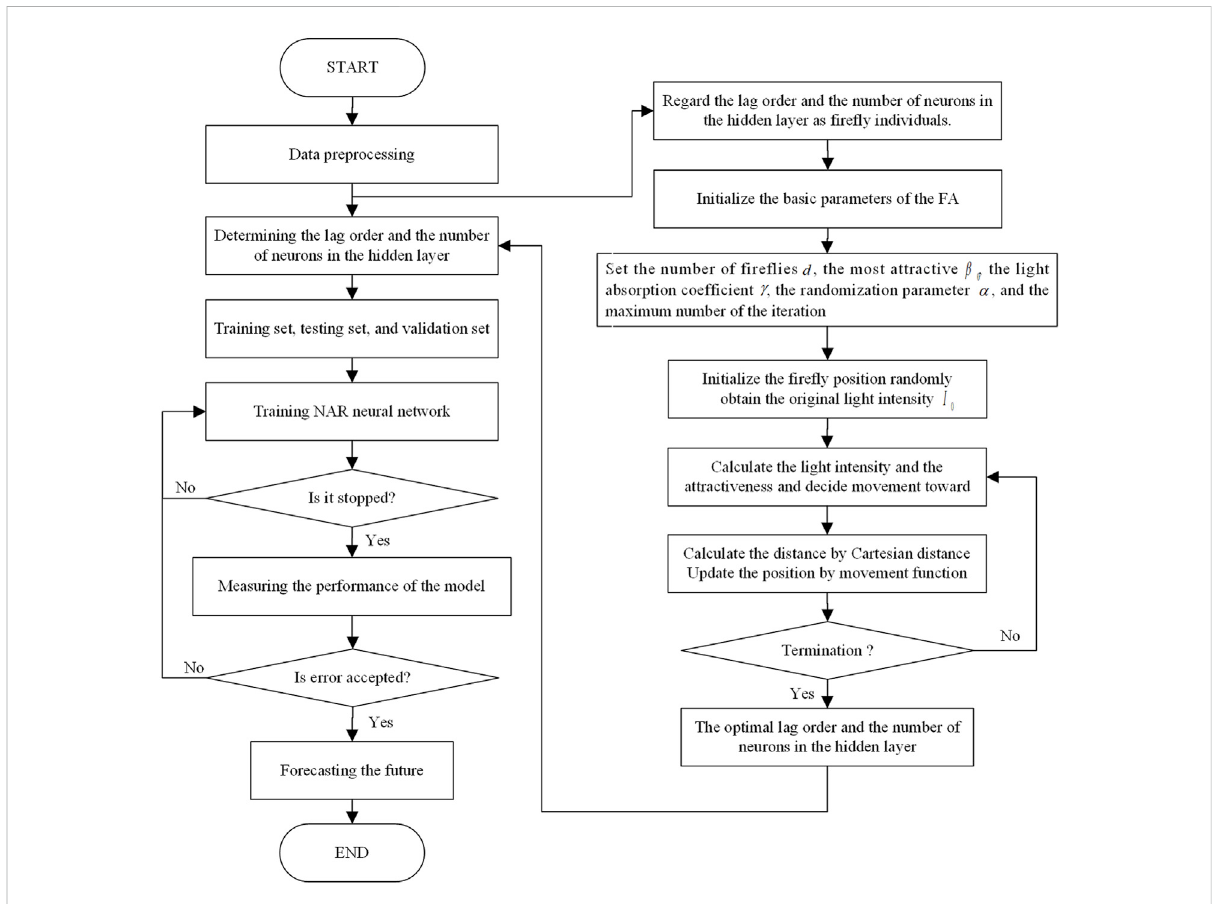
FIGURE 4 The fl owchart of the FA-NAR